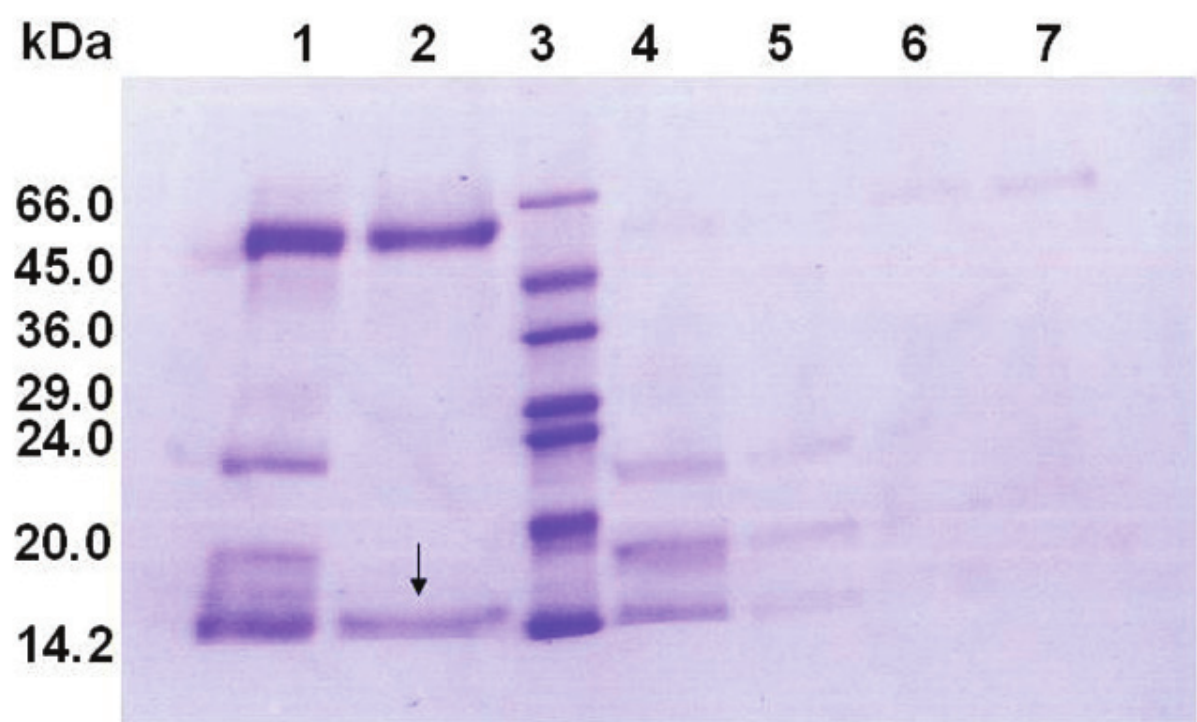
Figure 3. SDS-PAGE comparison of the whole venom and phases from partitioning experiment, under reducing conditions: Lane 1: venom. Lane 2: B Molecular weight markers (Sigma) bovine albumin (66 kDa), egg albumin (45 kDa), glyceraldehyde-3- phosphate dehydrogenase (36 kDa), carbonic anhydrase (29 kDa), trypsinogen (24 kDa), trypsin inhibitor (20 kDa), and a -lactalbumin (14.20 kDa). The arrow indicates a band of 14